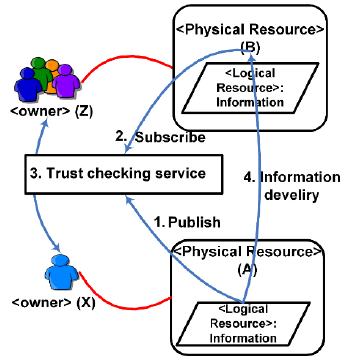
Figure 8. Information sharing process.